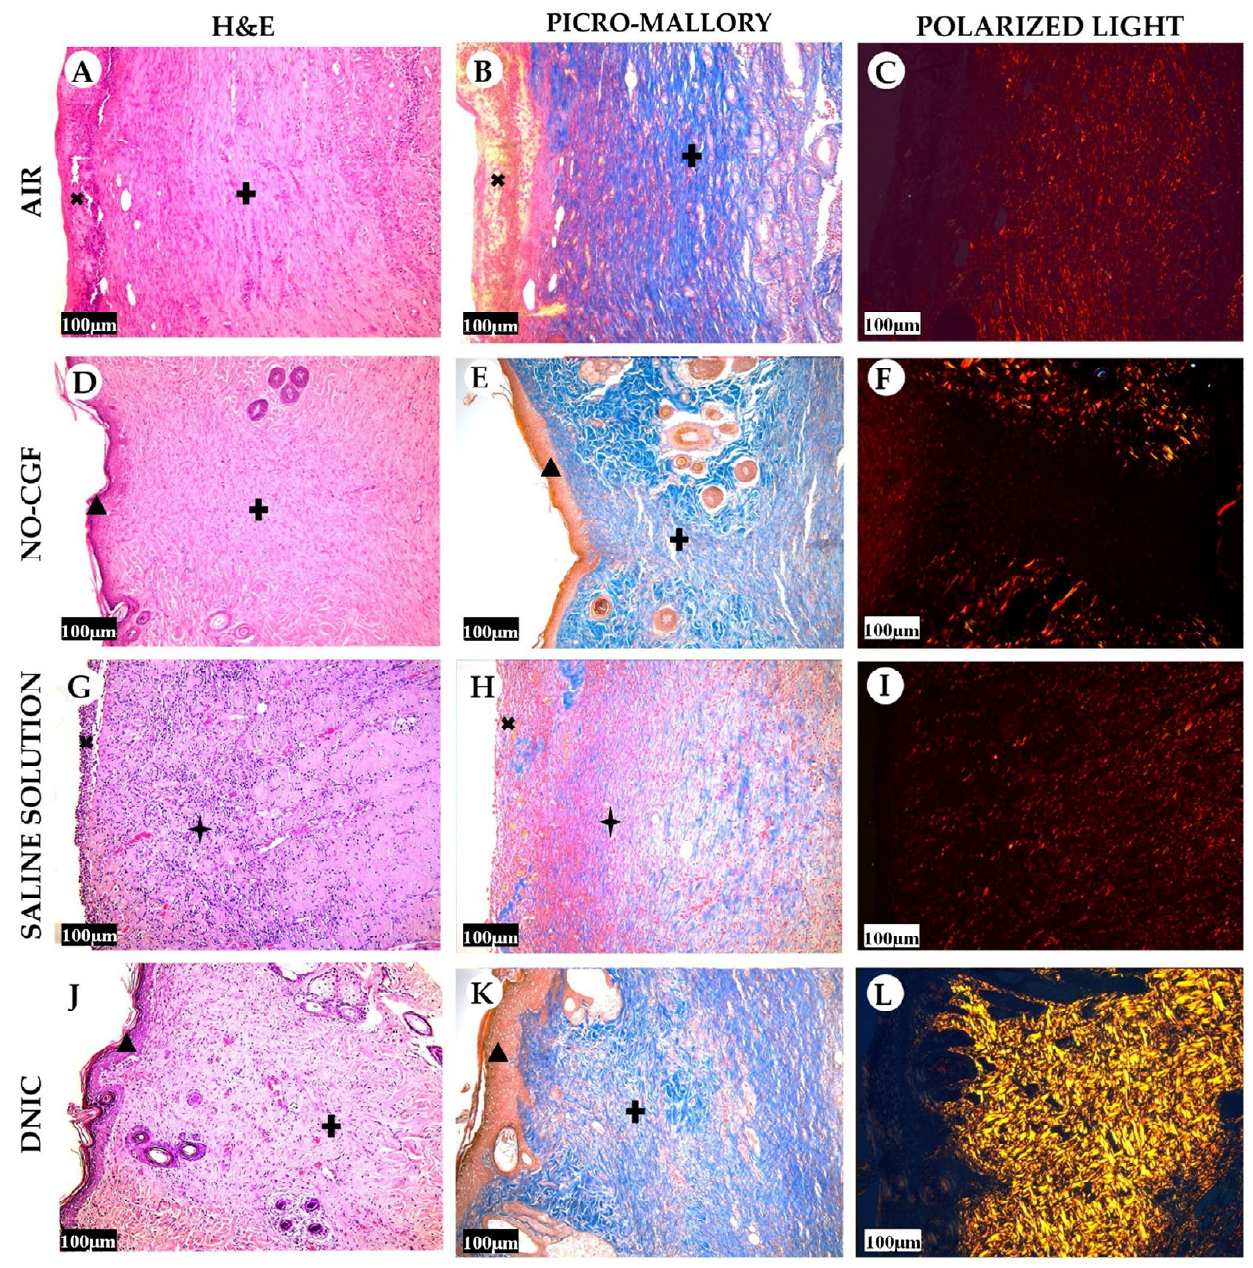
Figure 15. Histology of the wounds at post-operative day 21, hematoxylin and eosin staining ( A , D , G , J ), picro-Mallory staining ( B , E , H , K ) staining and polarized light microscopy ( C , F , I , L ); scale bar—100 µ